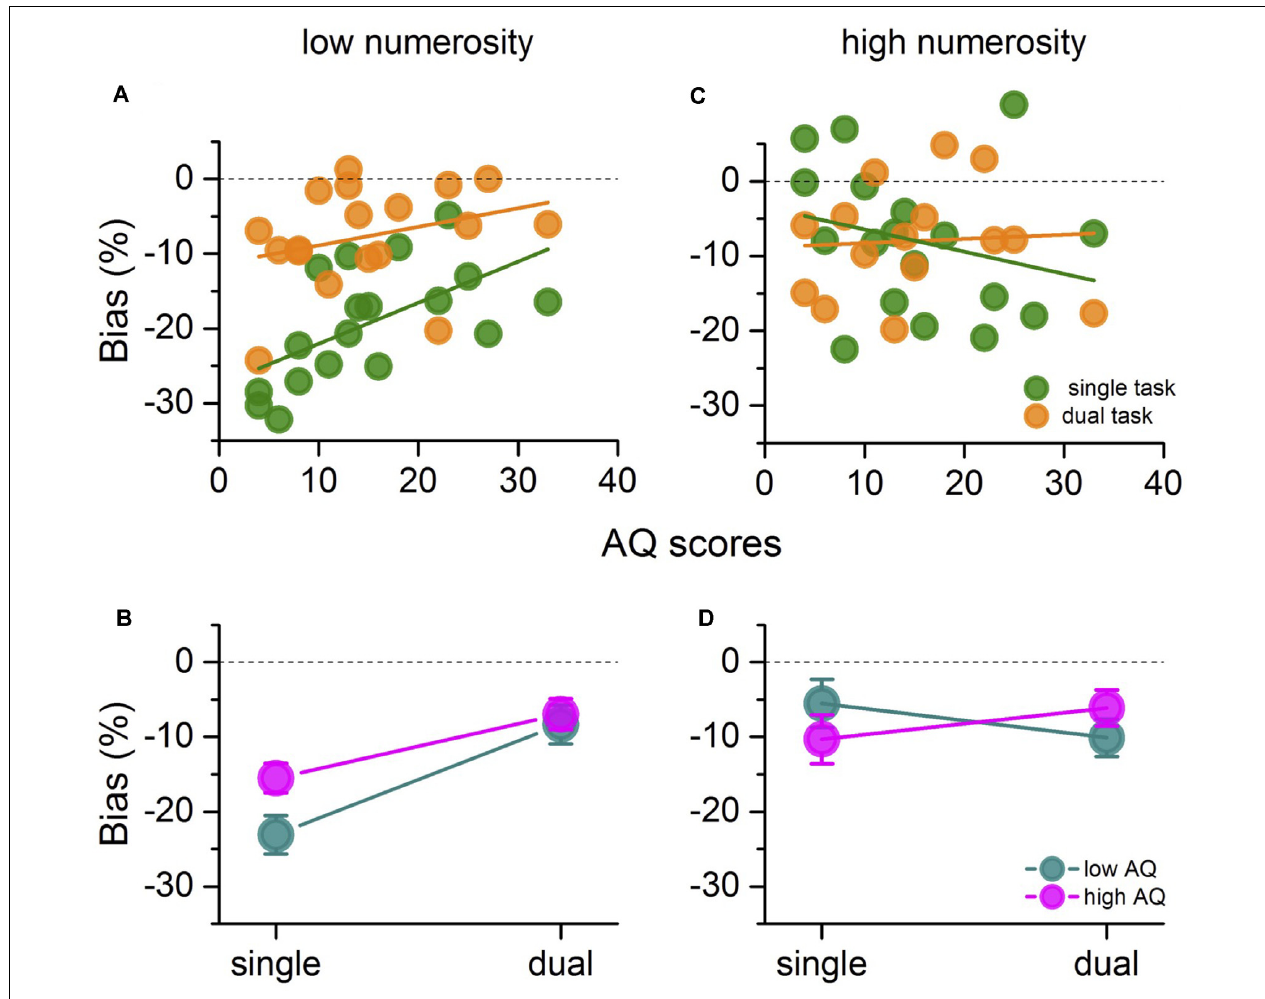
FIGURE 3 | (A) Mean bias at low numerosities (N15-N25) plotted against AQ for all participants, for single- (green) and dual-task (orange). Thick green and orange lines show the linear fit of the data. (B) Mean underestimation bias for low (cyan) and high AQ (magenta), with error bars = ± 1 SEM, plotted as a function of the two tasks. (C,D) Same as in (A) and (B) but for high numerosity